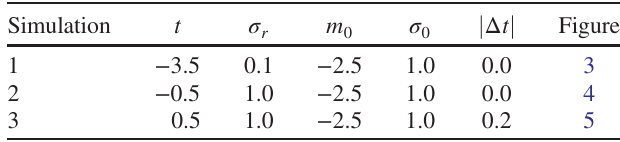
TABLE I. A summary table of all the simulations presented from the number guess environment. All simulations were done within a range of ½ − 5 ; 5 (cid:2)